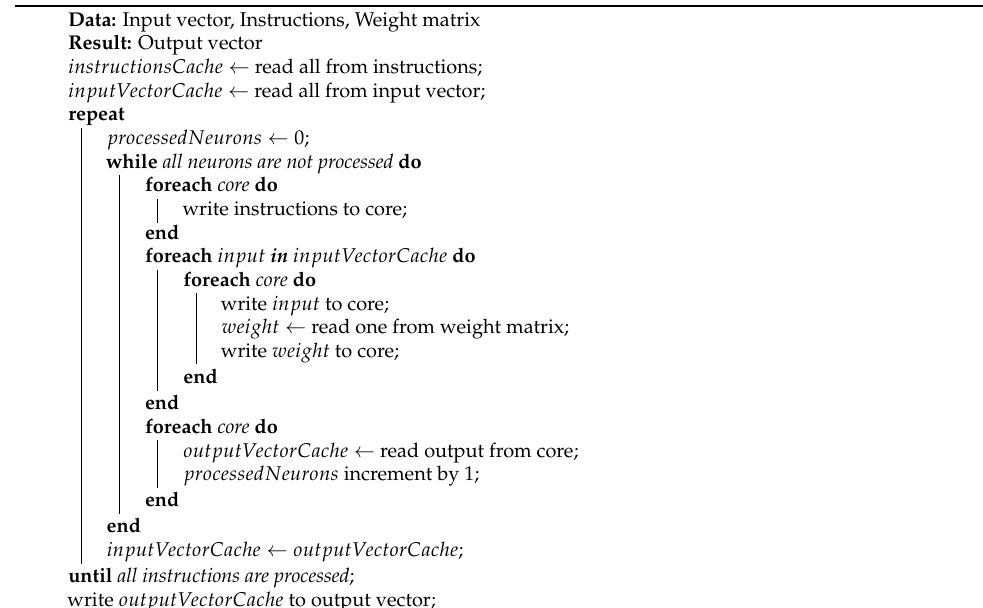
Algorithm 1: Scheduler module algorithm.